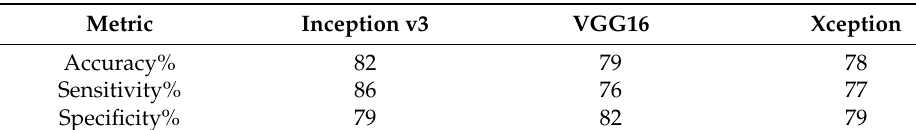
Figure 2. Detection of periapical areas (PRA) on panoramic radiograph by clinicians and by the AI. First image: OPG showing the PRA annotated by the expert clinician. Second image: OPG showing the proposed PRA generated by the detection model for the same image. All PRAs were detected by the proposed model (Faster RCNN). Table 2. Evaluation of the performance of the different classification models tested.